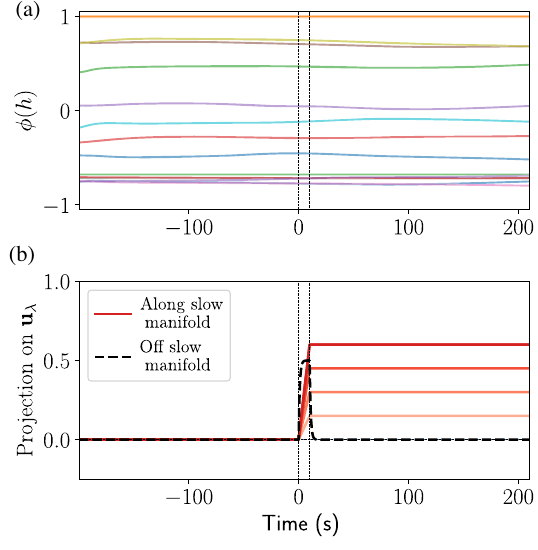
FIG. 2. Network in the marginally stable state functions as an integrator. (a) Sample traces from a network with switchlike 30 ; g 3 Þ show slow evolution (time on update gates ð α z ¼ h ¼ x axis is relative to τ ). (b) An input is applied to the same h network in (a) from t ¼ 0 till t ¼ 10 , either aligned with a slow eigenvector u λ (red traces) or unaligned with slow modes (black dashed trace). The plot shows the excess projection of the network state on the left eigenvector u λ . Different shades of red correspond to different input strengths. If the input is along the slow manifold, the trace of the input is retained for a long time after the cessation of input. [The traces in (a) are for the network with an input along the